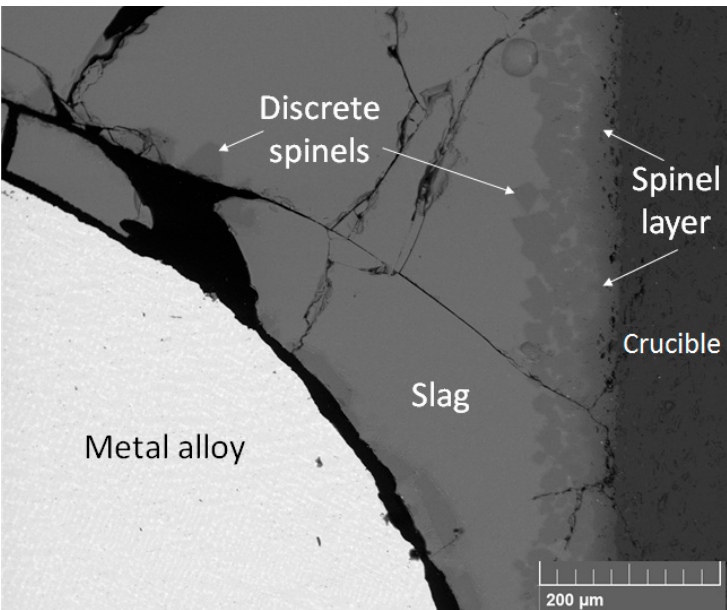
Figure 1. A typical sample microstructure (p(O 2 ) = 10 − 8 atm, 6 wt% of MgO in the slag mixture).